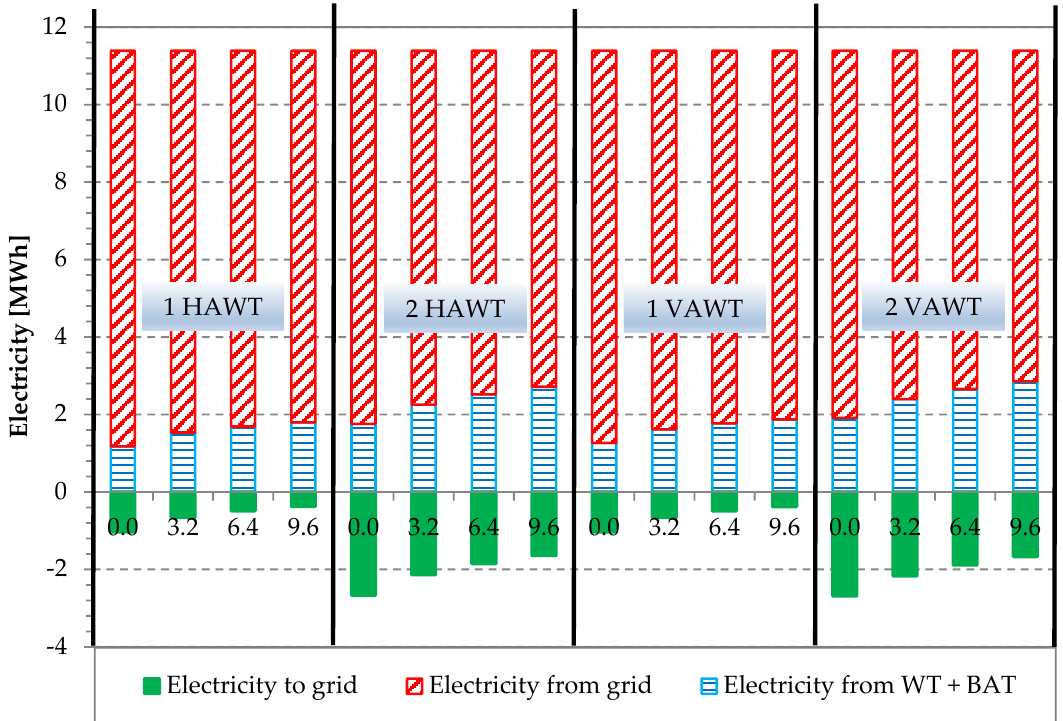
Figure 10. Electricity distribution for Naples as a function of WT configuration and battery storage capacity.